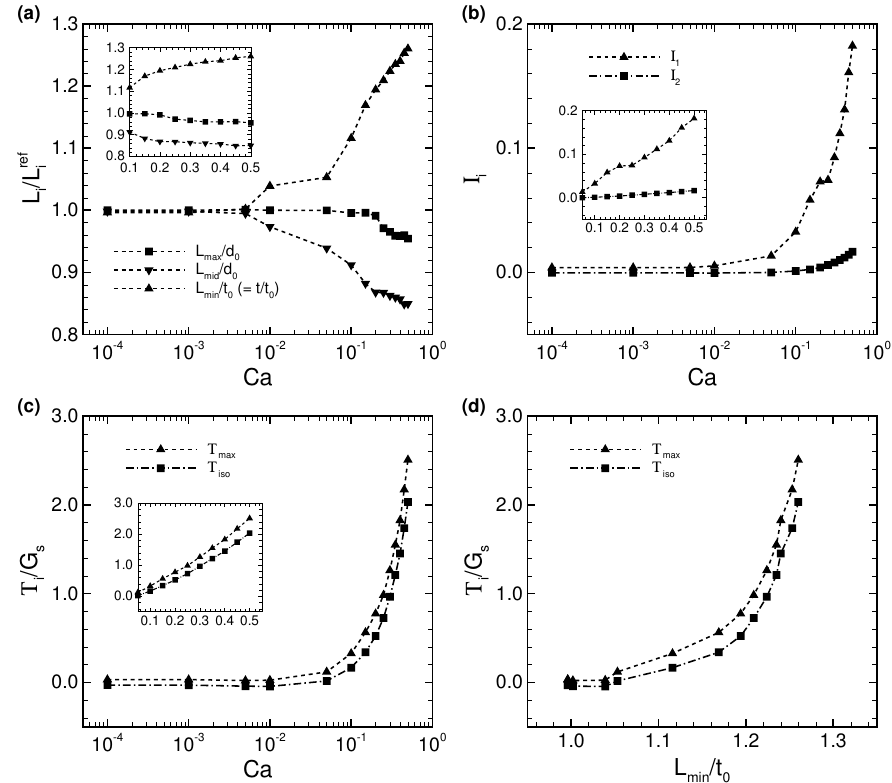
Figure 5. ( a ) Time average of the deformation index L i / L ref as a function of Ca , where the maximum, i middle, and minimum axis lengths ( L max , L min , and L mid , respectively) are normalized by each reference length L ref (i.e., no flow condition), where the reference major and minor axis lengths are d 0 and t 0 i (thickness), respectively. ( b ) Averaged first and second invariants I i ( i = 1 and 2) as a function of Ca . ( c ) Averaged maximum and isotropic tensions; T max and T iso , respectively. These values are normalized by the shear elastic modulus G s . ( d ) The average of these tensions, T i , as a function of the deformation index L min / t 0 , which is the ratio between the minimum axis length of the deformed RBC (thickness) and the reference